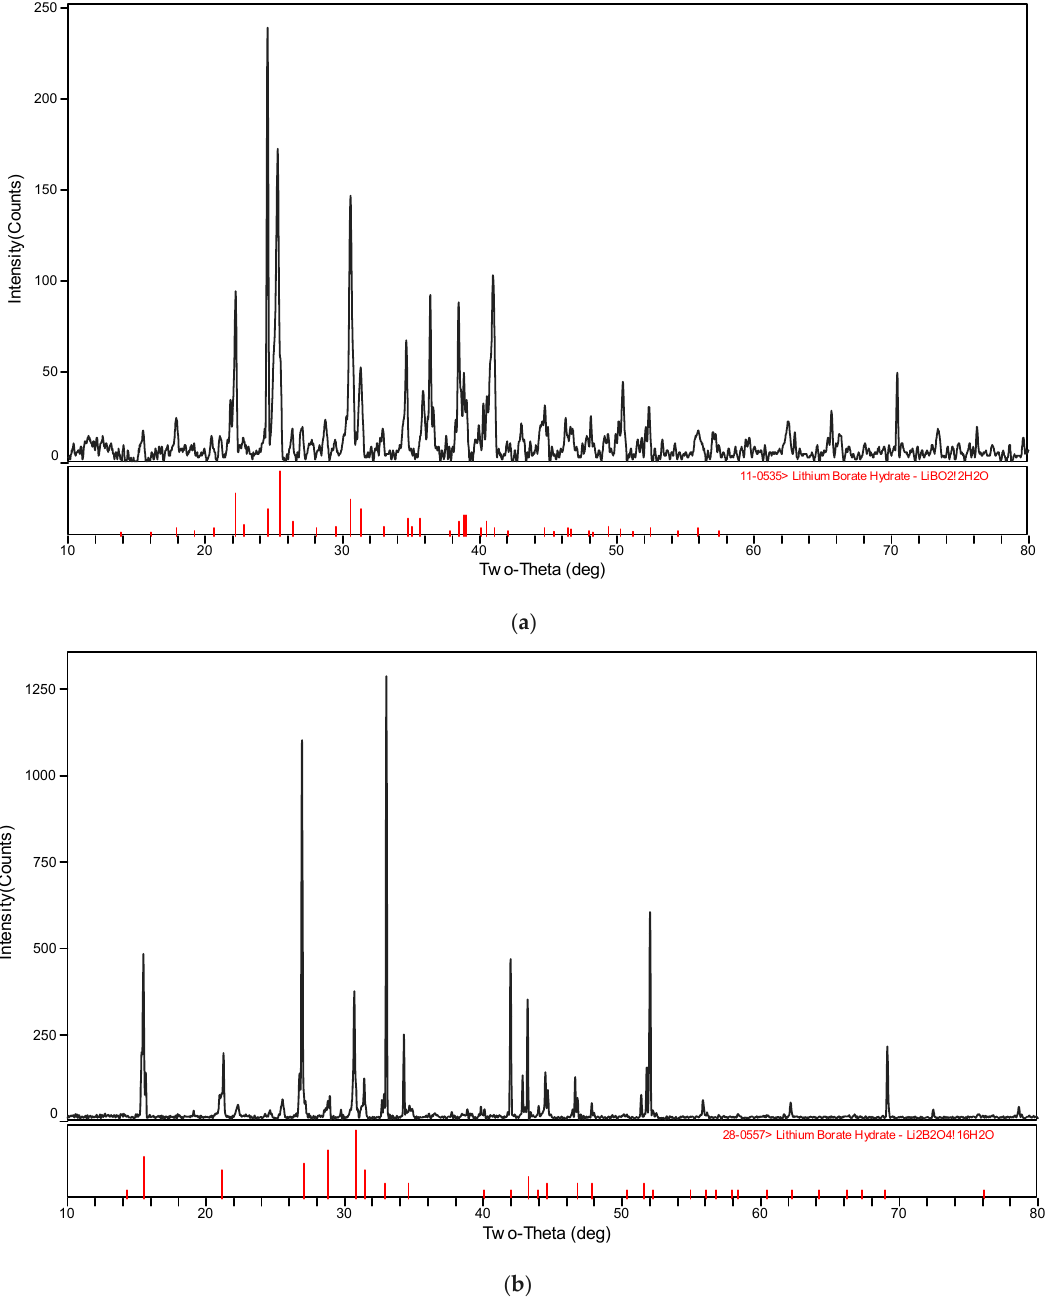
Figure 3. XRD pattern for ( a ) LiBO 2 ∙ 2H 2 O and ( b ) LiBO 2 ∙ 8H 2 O.